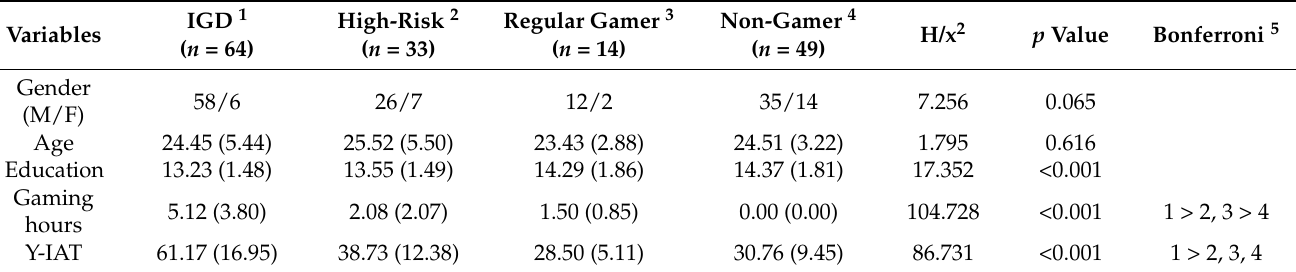
Table 2. Comparison of demographics among four groups ( n =